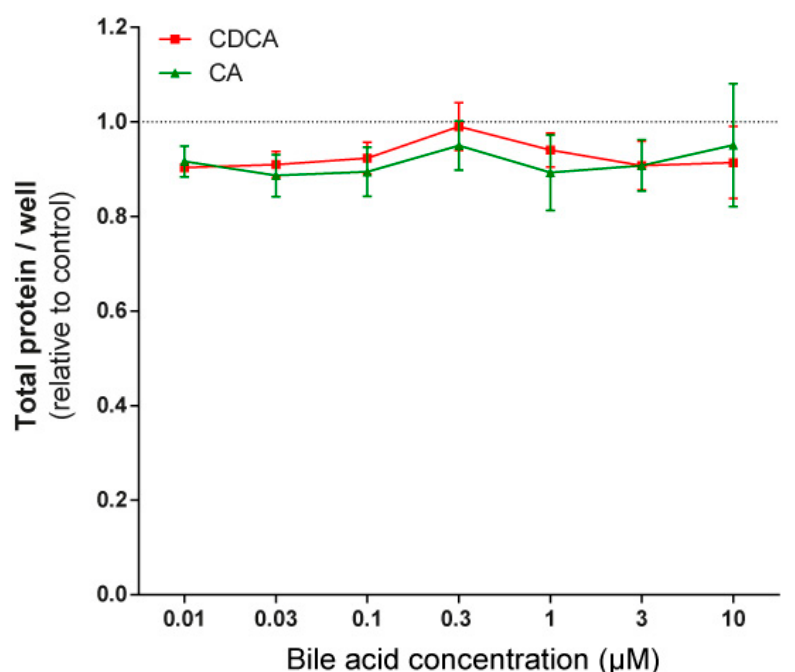
Figure 8. Primary bile acids did not affect the proliferation of 4T1 breast cancer cells. The 4T1 cells were treated with CA and CDCA in the concentrations indicated for 48 h, then total protein concentrations were determined by sulforhodamine B assay ( n = 4). Data are plotted as mean ± SEM. (CA, cholic acid; CDCA, chenodeoxycholic acid).